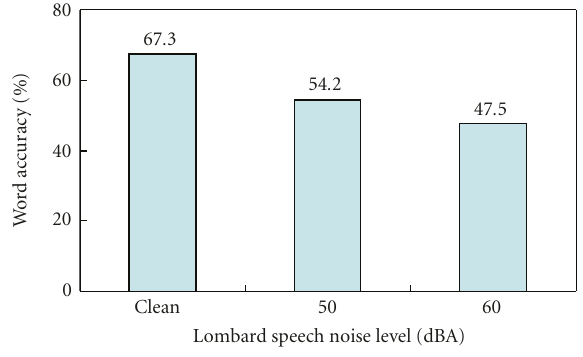
Figure 13: Nonaudible murmur recognition using Lombard